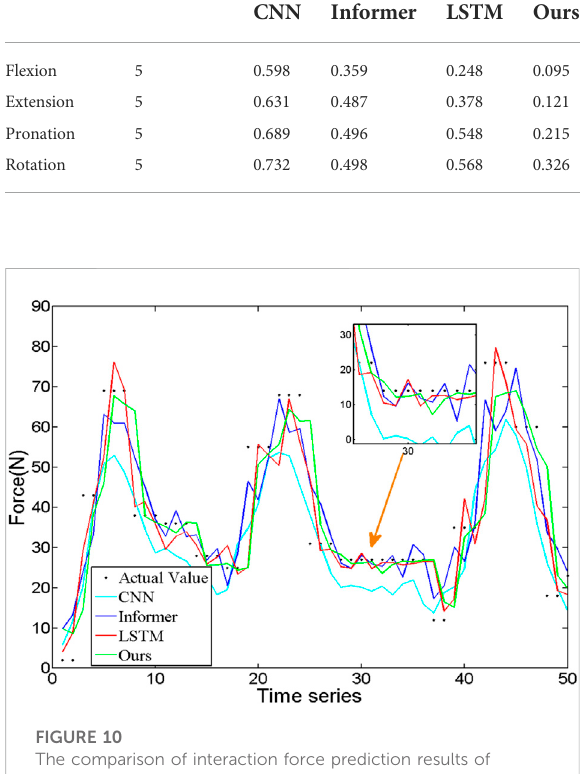
FIGURE 10 The comparison of interaction force prediction results of different